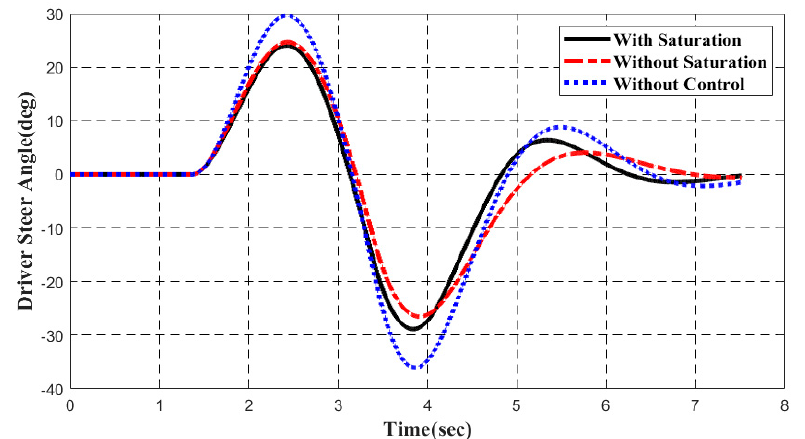
Figure 9. The simulation results for the steering angle.